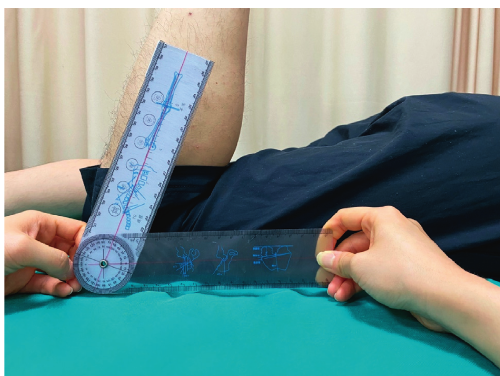
Figure 1: Therapist measuring the range of motion of the patient’s injured knee joint.